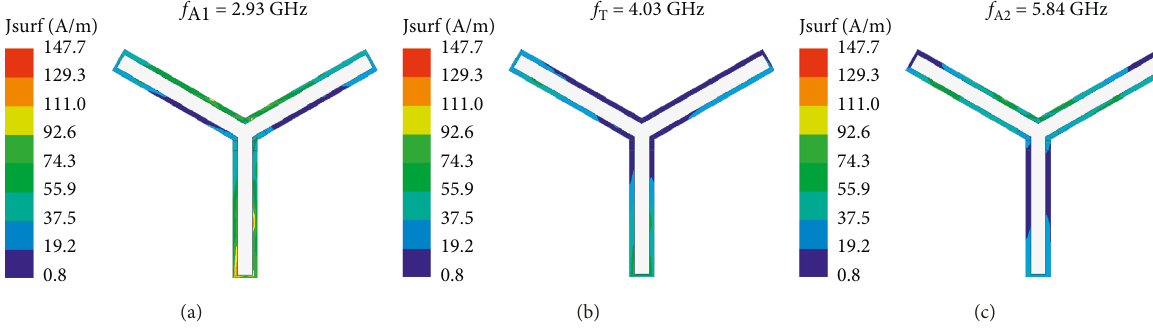
A1 : lower absorption frequency, (b) f T : parallel